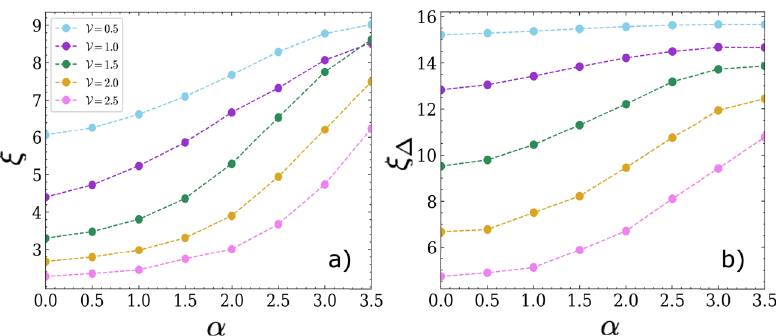
Fig. 5 Correlation lengths. a The BCS coherence length ξ . b The correlation length ξ Δ . Both quantities are calculated for a few selected values of V and are shown as functions of α . The dashed lines connecting numerically obtained points serve as guides for an